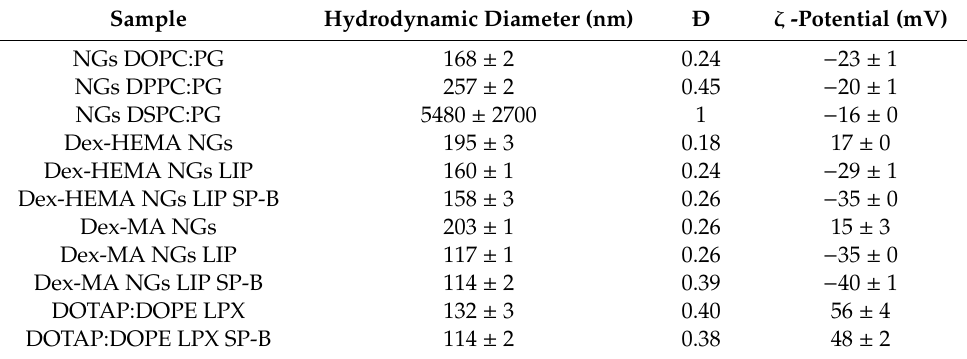
Table 1. Representative DLS data and ζ -potential of di ff erent formulations used in this study. Sample Hydrodynamic Diameter